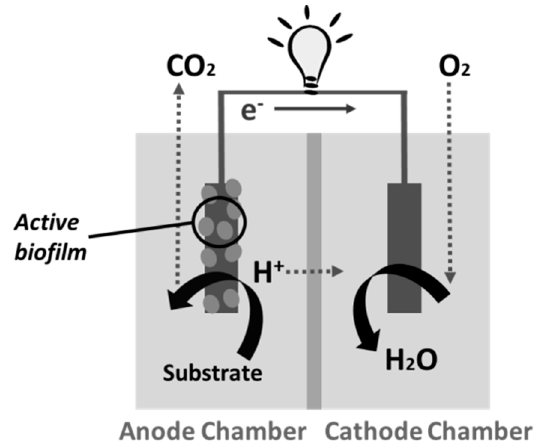
Figure 1. Schematic diagram of a MFC.